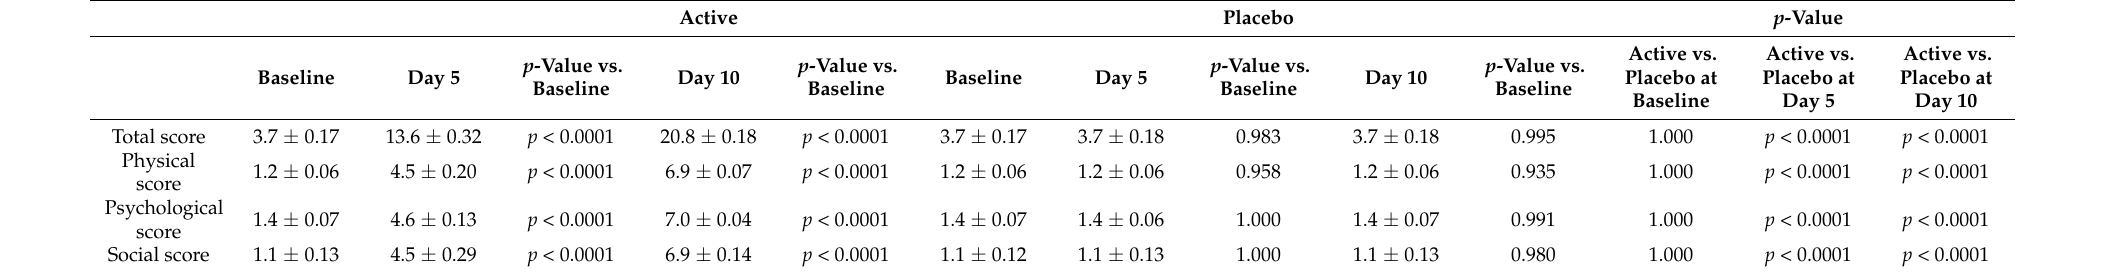
Table 3. LCQ core (mean ±